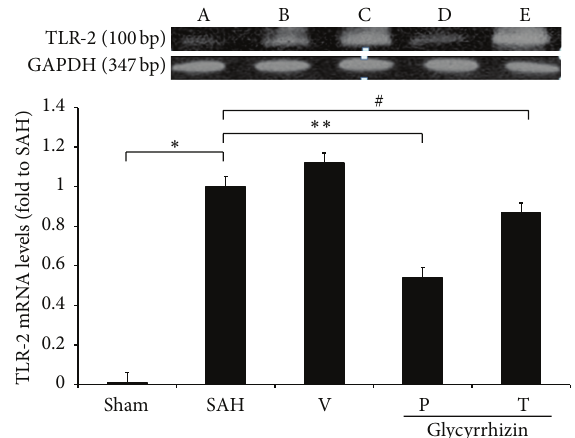
Figure 6: The activation TLR-2 mRNA among groups after induc- tion of SAH. All groups are identical to those shown in the legend of Figure 1. All values are mean ± SD ( 𝑛 = 9 ). ∗ , ∗∗ : 𝑃 < 0.01 , and # : 0.1 > 𝑃 > 0.05 compared with the SAH group.